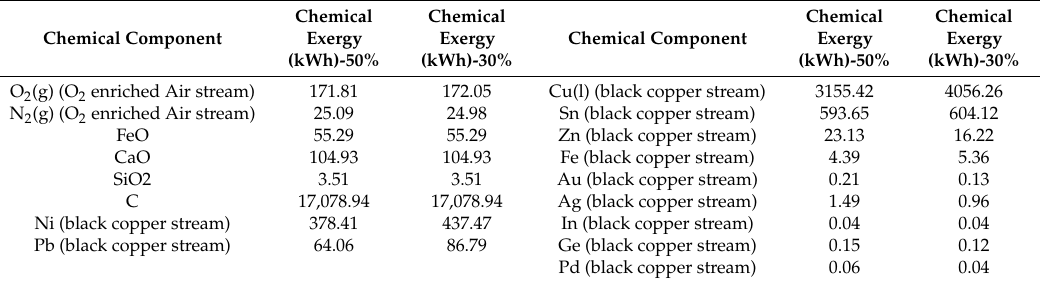
Table 6. Exergy values of materials going into the oxidation furnace.